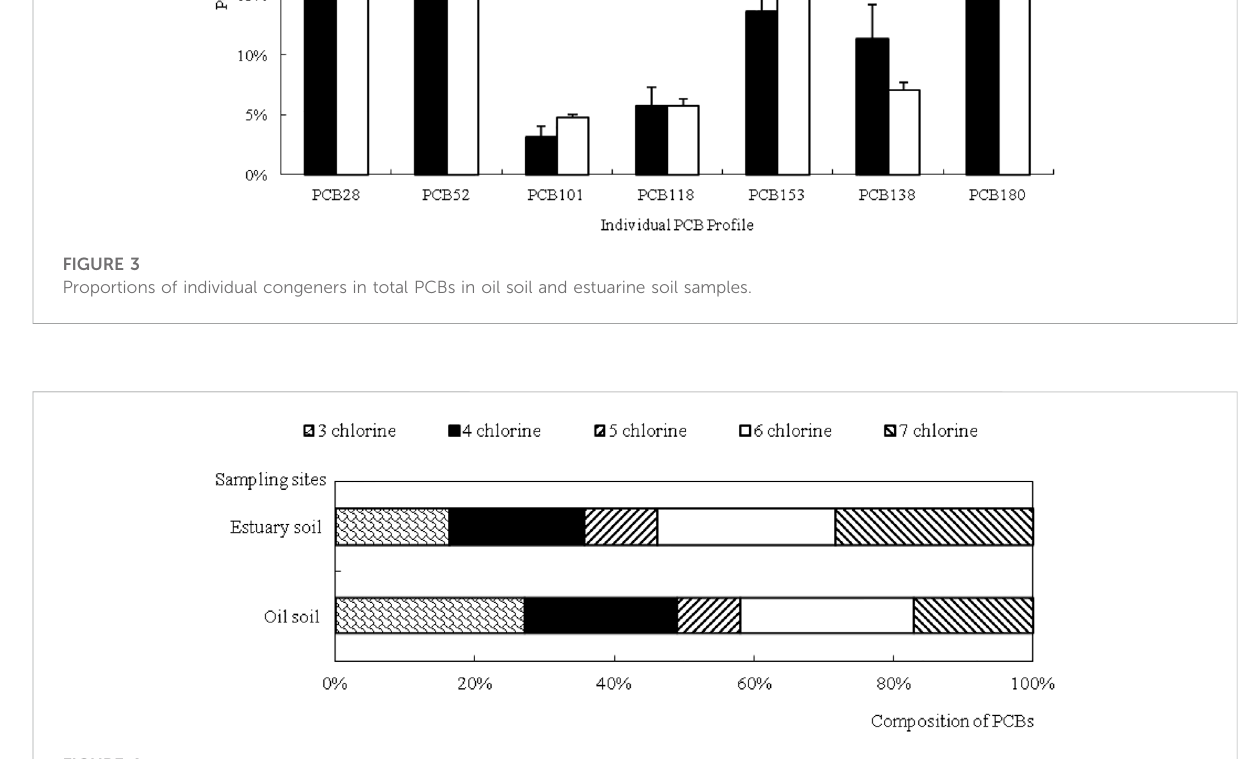
Figure 4. As illustrated in Figure 4, difference of the composition of PCBs was observed in the samples collected from the two different sites. The proportions of high-chlorine congeners (PCB101, PCB118, PCB153, PCB138 and PCB180) were 49.0%, and those of (PCB28 and PCB52) were 51.0% in Oil soil sites. The proportions are approximately similar between